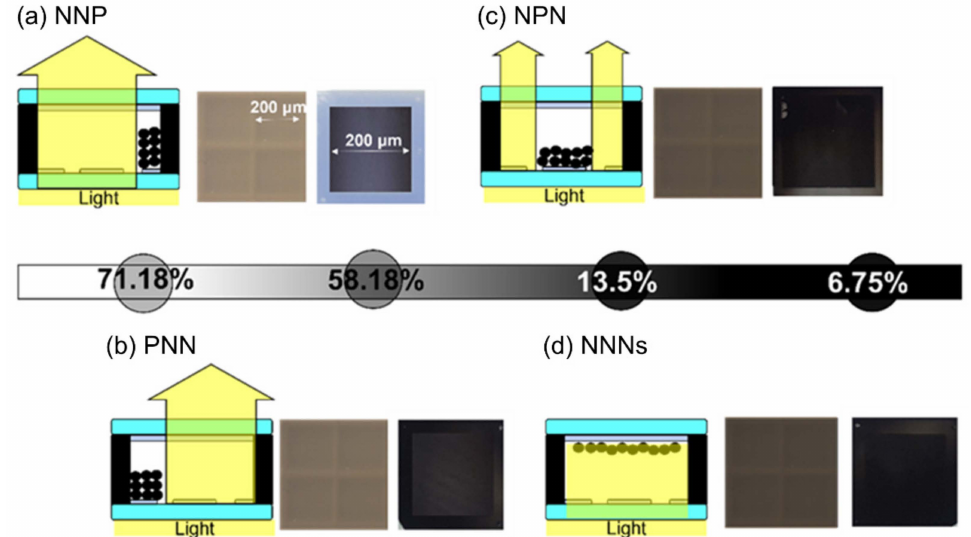
Figure 7. Schematic illustrations for the arrangement of the particles controlled by the voltage application and their transmittance from 6.8% to 71% in transmissive type E-paper with ( a ) NNP, ( b ) PNN, ( c ) NPN, and ( d ) NNNs bias.